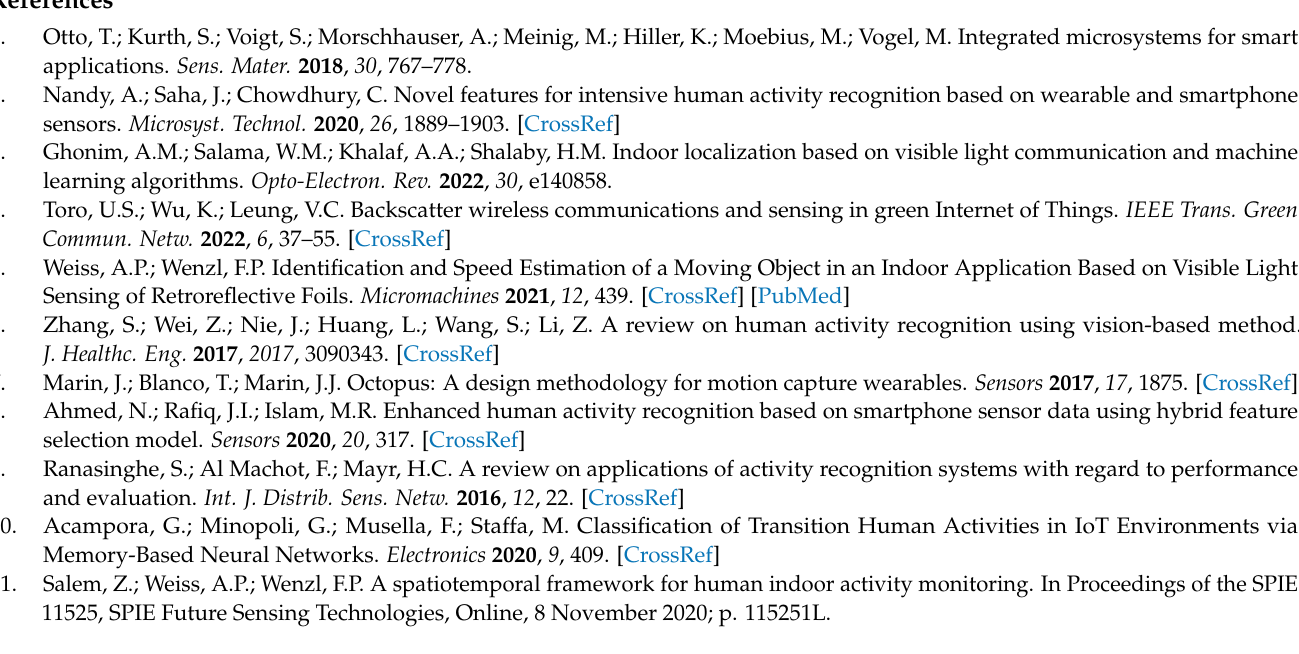
Figure B2. Comparison of spectral light distributions after switching on a LED in room 3. Measure-